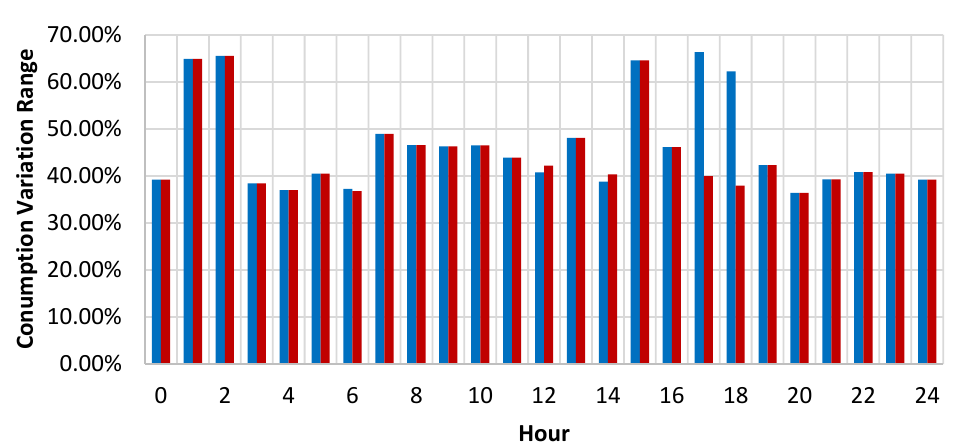
Figure 9. Energy consumption variation range compared to hourly average weekdays consumption for original and cleared data sets.